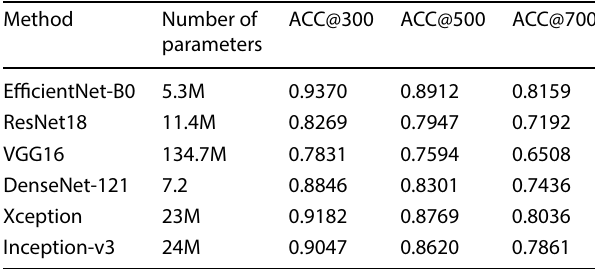
Table 2 Equal error rate and area under curve of the proposed method against increasing in the number of training classes Number of classes